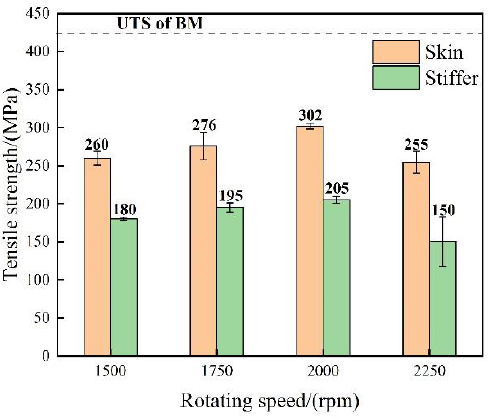
Figure 13. Tensile properties of the T-joint welded by SSFSW at different rotation speeds of the stirring pin.